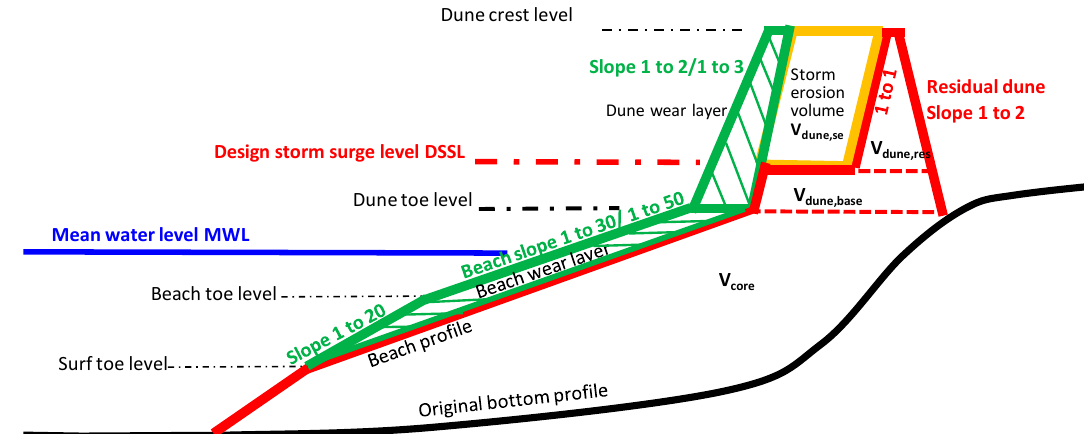
Figure 2. Cross-shore profile of beach-dune system.